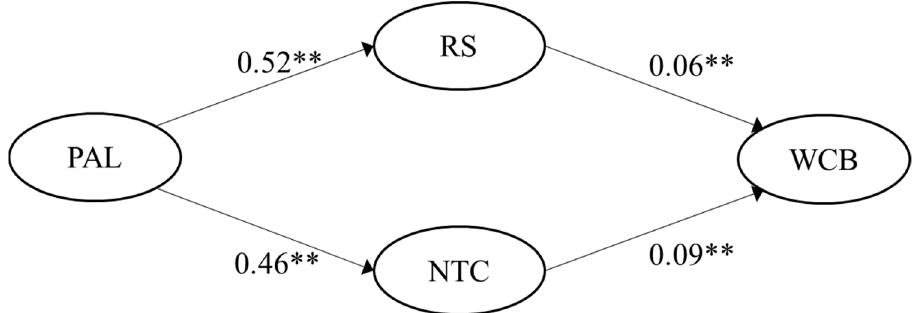
Figure 3. Empirical multiple mediation model for passive ‐ avoidant leadership for the German sam ‐ ple (n = 334). Note: ** indicates a p ‐ value < 0.01; PAL = Passive ‐ avoidant leadership; RS = Role stress; NTC = Negative team climate; WCB = Workplace cyberbullying.